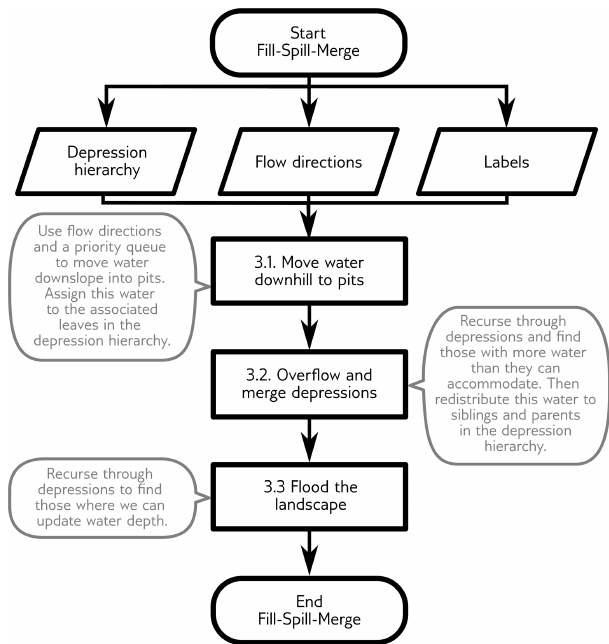
Figure 5. Flowchart showing the main steps taken by the algorithm. These steps are described in more detail in Sect. 3.1 to